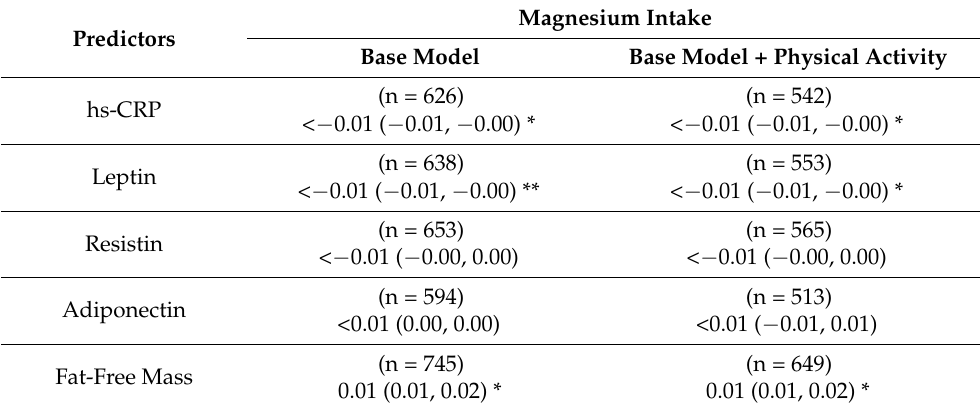
Table 2. Regressions of magnesium intake on cardiometabolic risks.